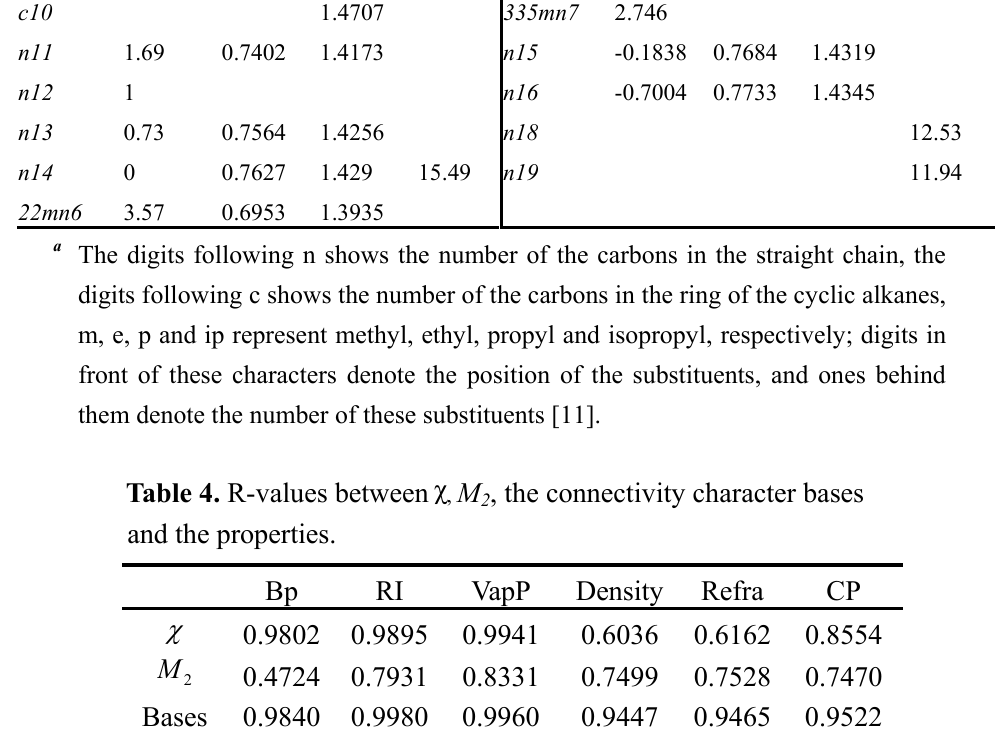
Table 4. R-values between χ , M